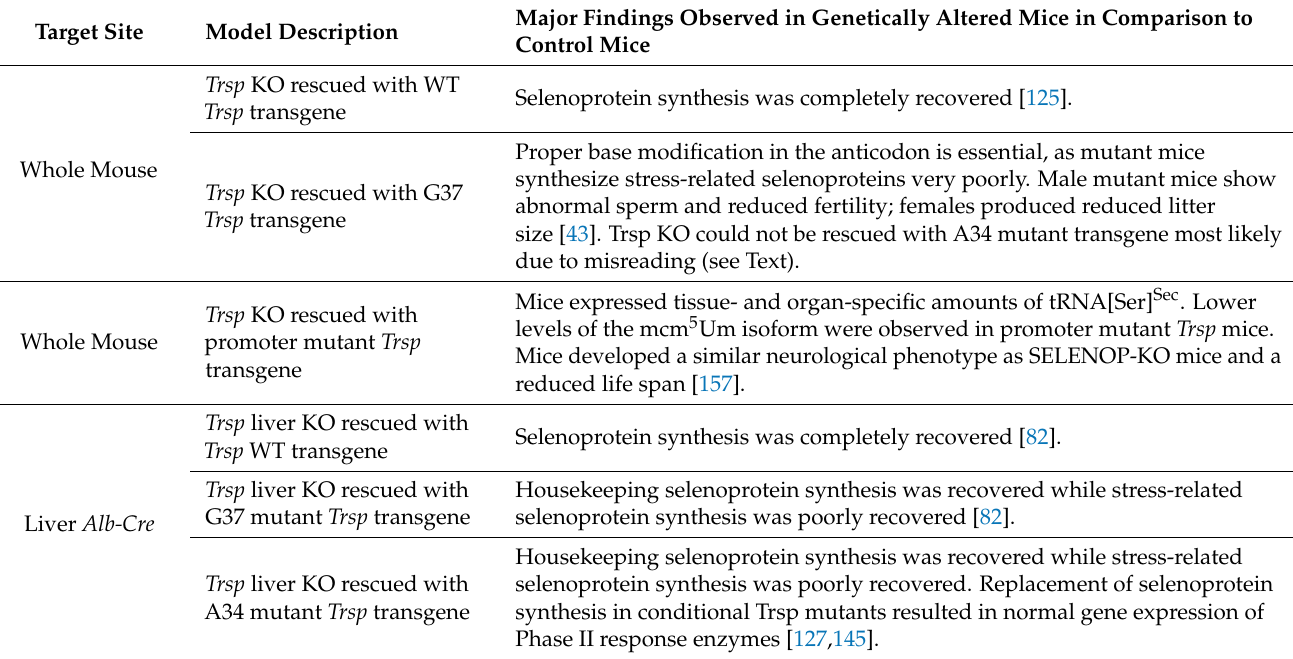
Table 4. Mouse models involving Trsp knockout (KO) or Trsp conditional KO mice rescued with wild-type (WT), G37 mutant, or A34